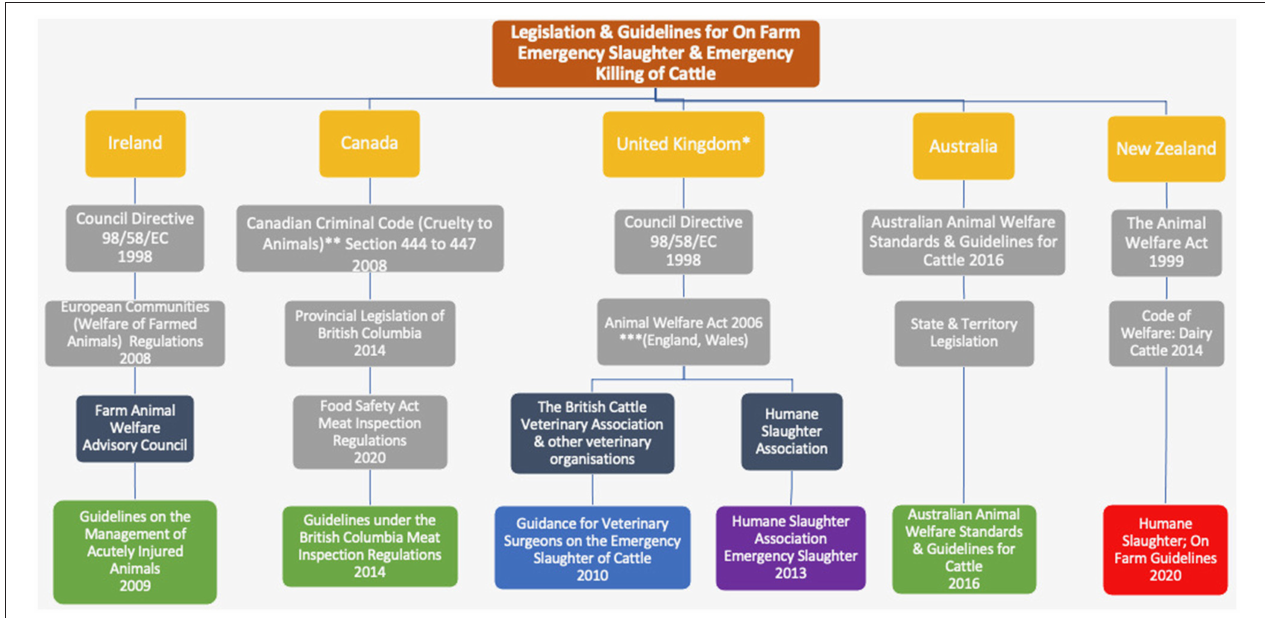
FIGURE 2 | Legislation and guidelines for on farm emergency slaughter and emergency killing of cattle in Ireland, the United Kingdom, Australia, New Zealand and British Columbia, Canada (Yellow) in 2020. Legislation (light grey), organisation (dark grey), competent authority and supporting bodies (green), National Veterinary Organisations (blue), Animal Welfare Charity (purple), industry (red). *The EU regulations were binding in the United Kingdom until 1st january 2021; **Applies federally to the province of Canada; ***Similar legislation pertains in Scotland & Northern